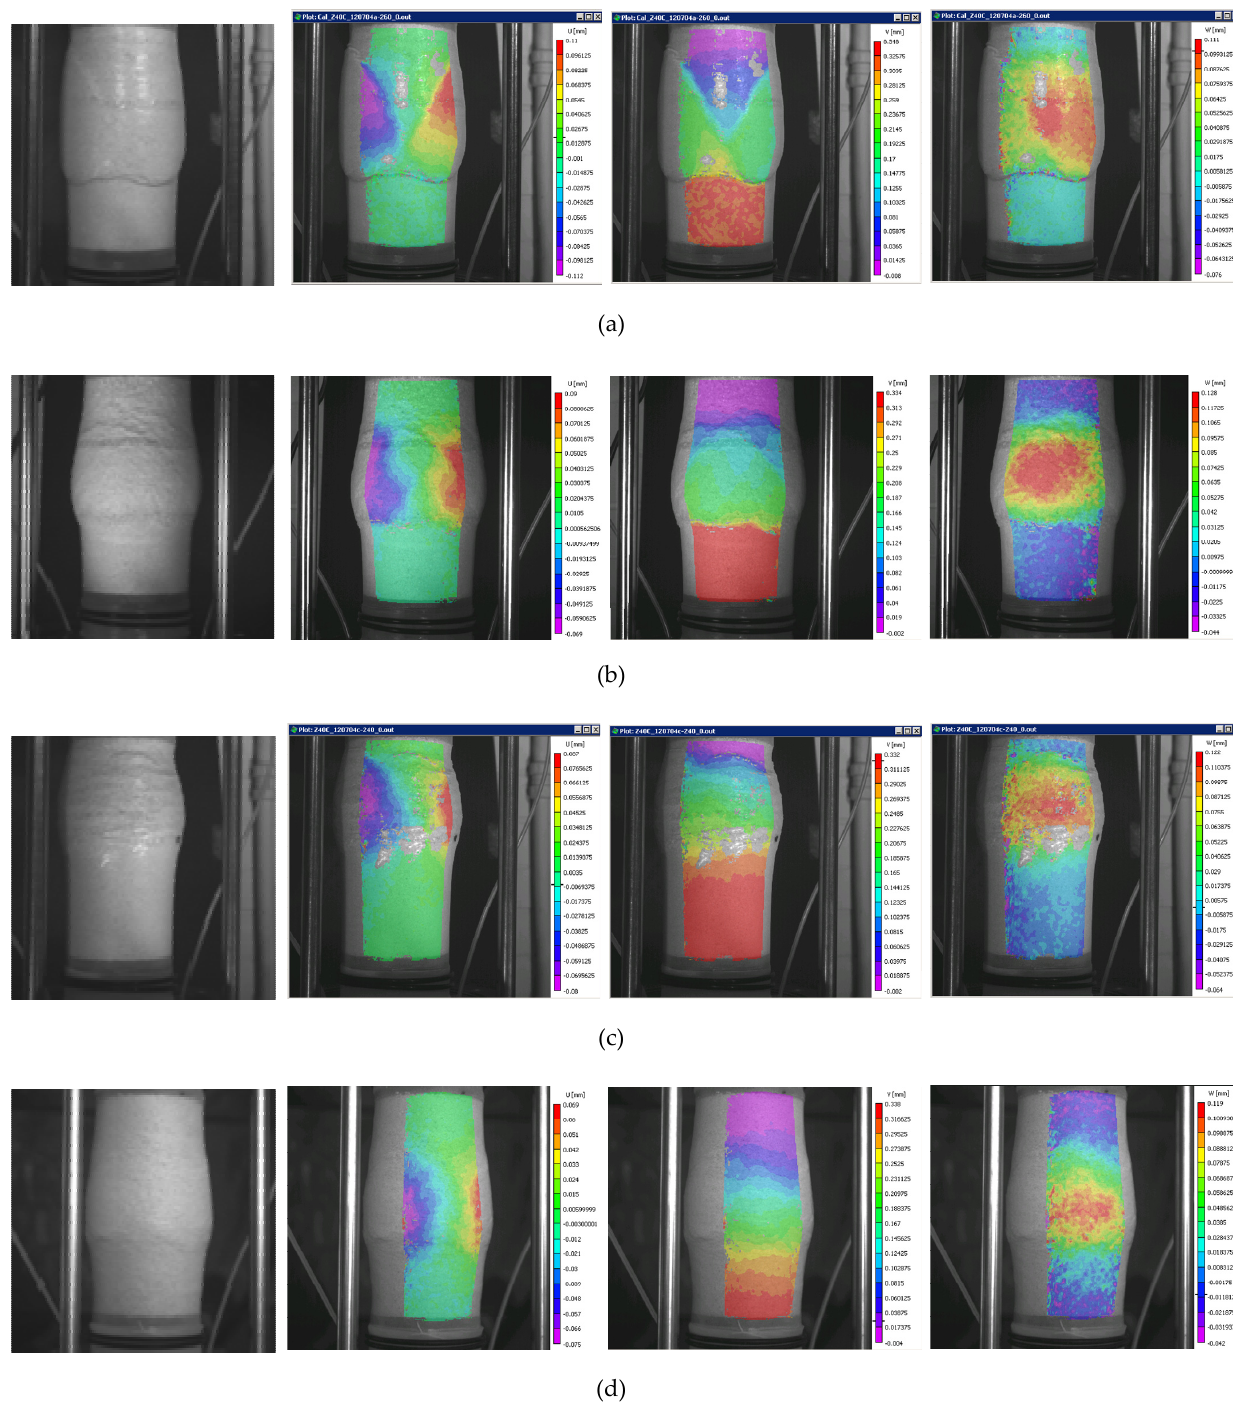
Figure 12 . Different localization effects at failure. Digital images and corresponding displacement fields (u , v , and w) at 12% of axial strain from tests 120704a ( a ), 100103c ( b ), 120704c ( c ), and 121304b ( d